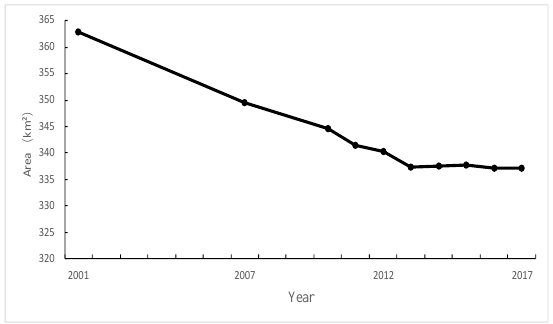
Figure 8 Area changes of Jiaozhou Bay in recent